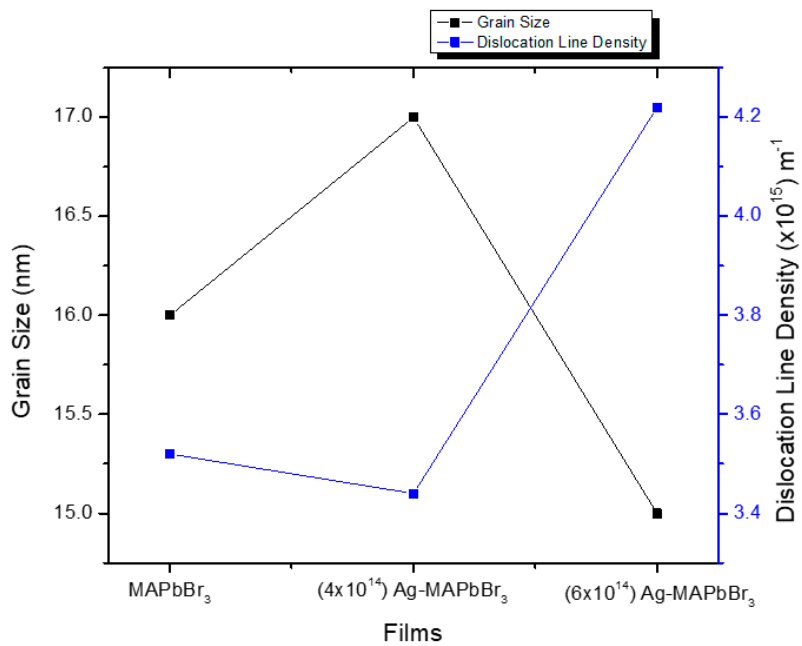
Figure 3. δ and D of pure and Ag ion-irradiated MAPbBr 3 . δ Figure 3. and D of pure and Ag ion-irradiated MAPbBr 3.